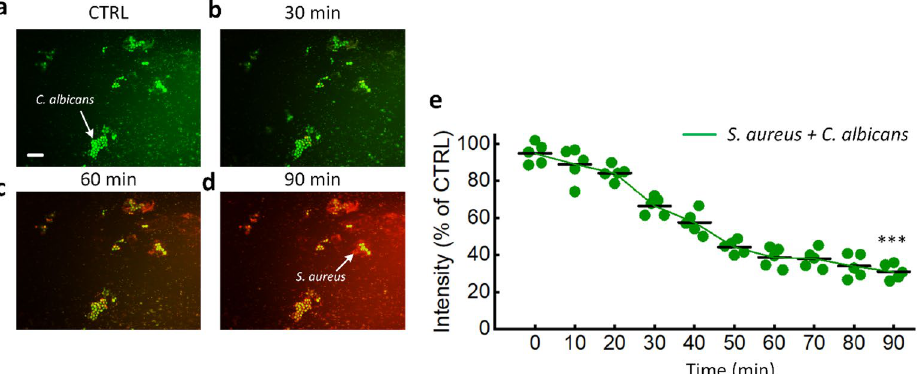
Figure 7. Laser treatment of the dual-species biofilm ( S. aureus + C. albicans ) under a flow rate of 1 µL/min: ( a – d ) time-lapse images of the samples after treatments for 0, 30, 60, and 90 min, respectively, and ( e ) green intensities measured from the untreated control (0 min) and treated samples (CTRL: untreated control; scale bar = 20 μm; *** p < 0.01 vs. untreated control; N =